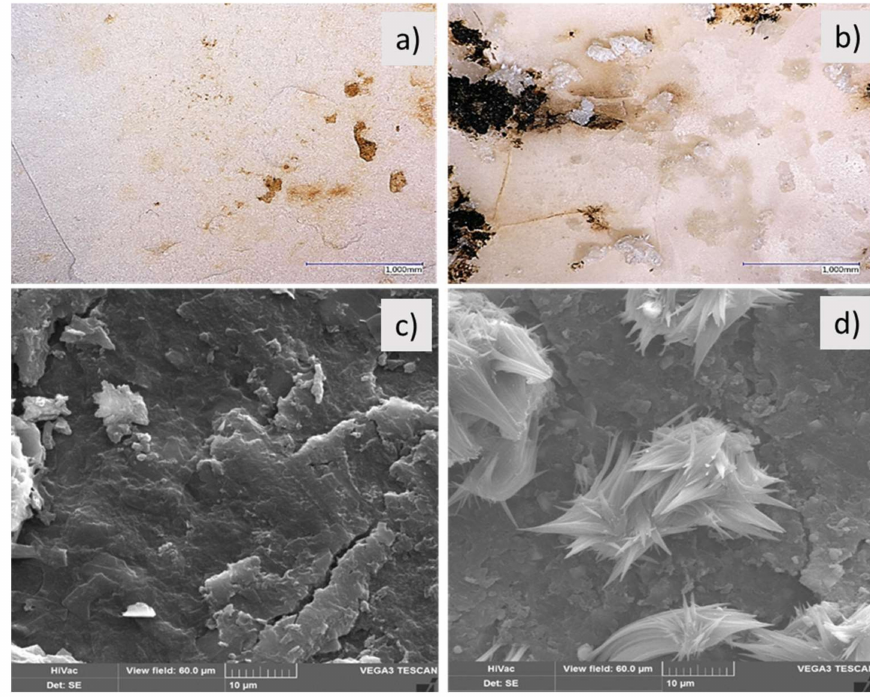
Figure 7. Comparison between fine talc (V08, ( a , c )) and chalk (V09, ( b , d )) loaded PLA/PBS (7:3) blend systems after 6 weeks (( a , b ), pictures above ) and 12 weeks (( c , d ), pictures below ) of disintegration under industrial composting conditions, each by loading 15 phr filler amount. Upper pictures using digital light microscopy, pictures below SEM photographs.